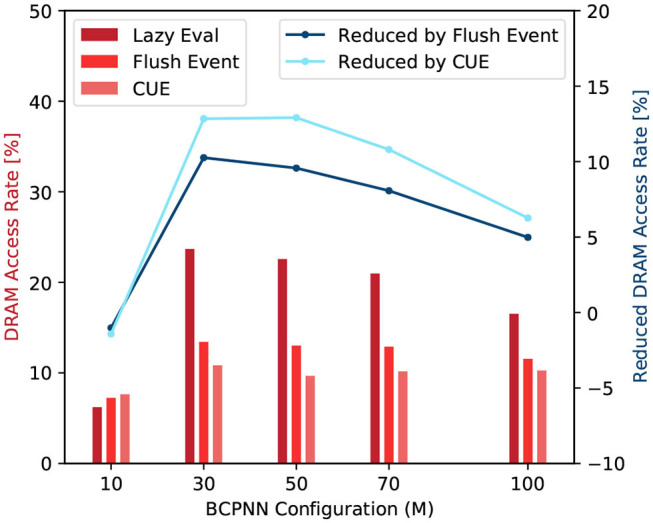
DRAM access rate comparison (red) and DRAM access rate reduction by the flushing event method and the CUE method (blue).